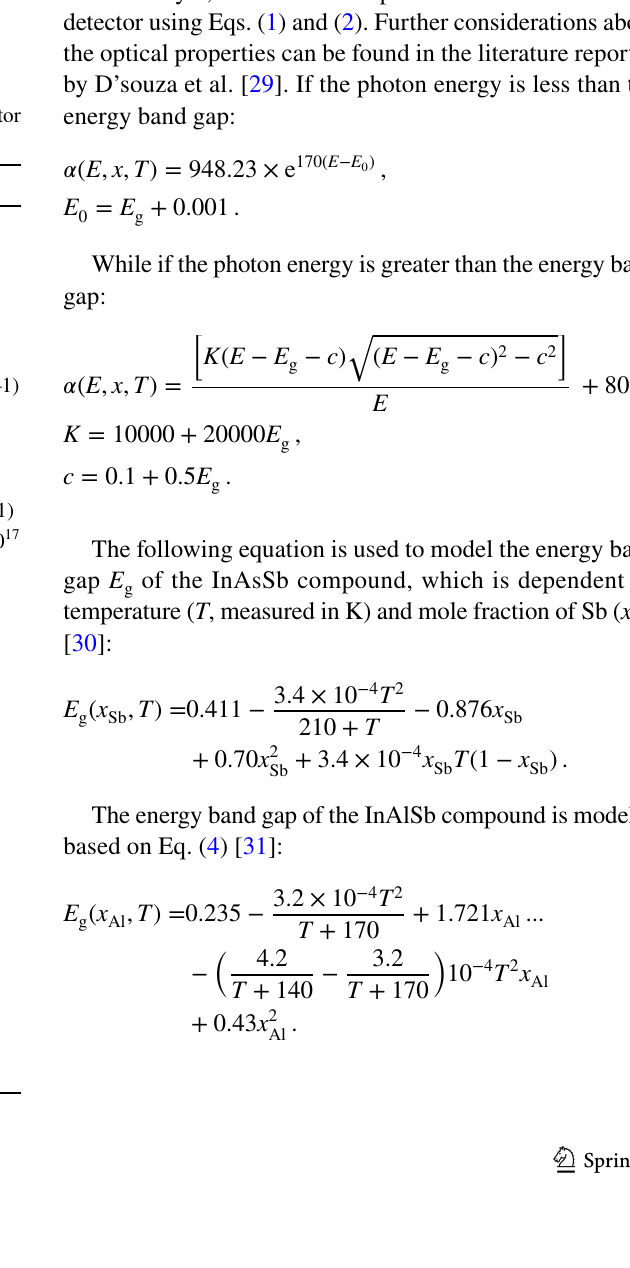
Fig. 1 Schematic of the proposed InAsSb nBn photodetector struc- ture